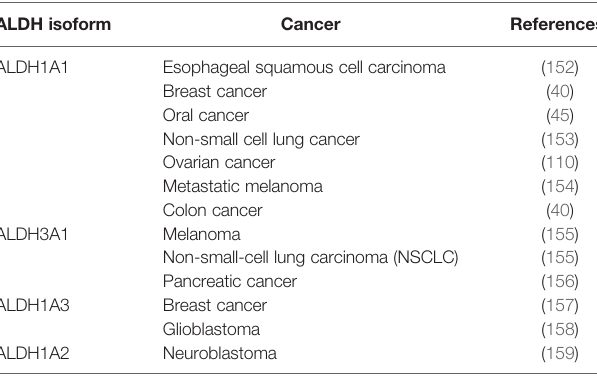
TABLE 4 | ALDH isoforms as markers of